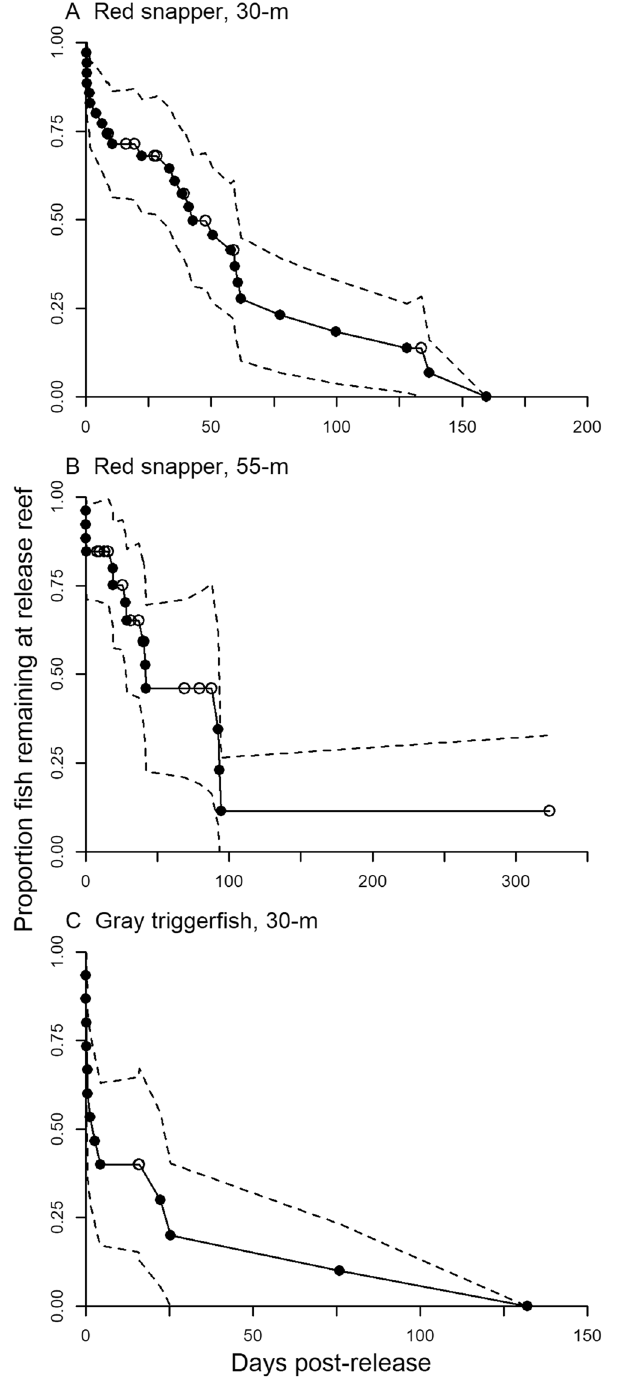
Figure 2. Kaplan–Meier estimated (with 95% CI) release reef residency of red snapper in the ( A ) 30-m array and ( B ) 55-m array, and ( C ) gray triggerfish in the 30-m array. Filled symbols mark when tagged fish moved away from the release reef and open symbols represent right censored